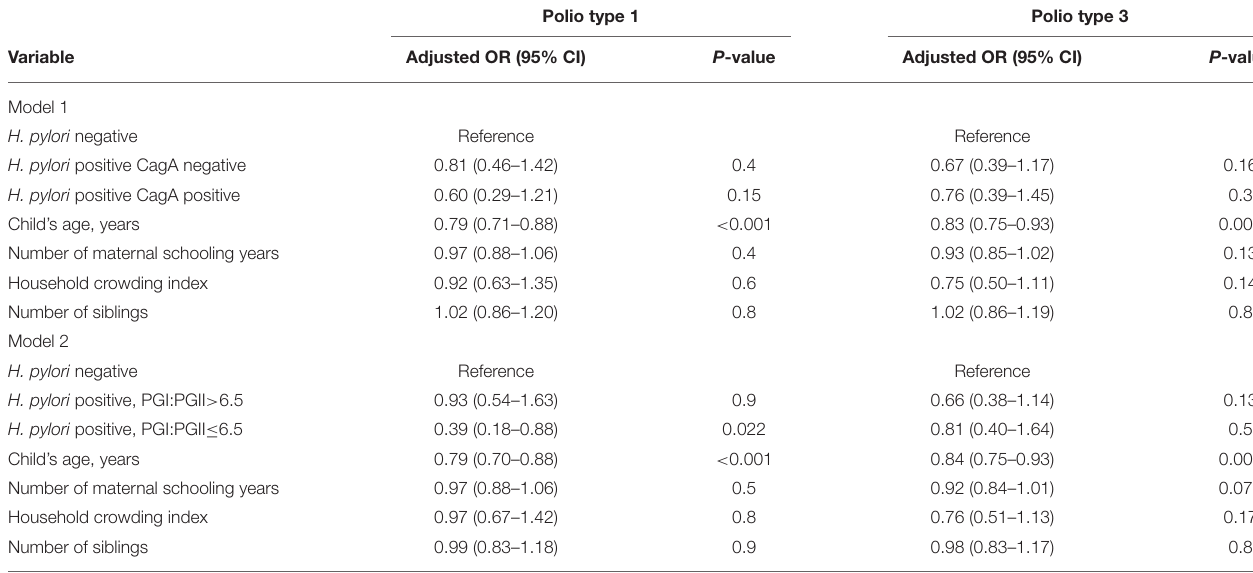
TABLE 5 | Unweighted multivariable logistic regression models of factors associated with high serum neutralizing antibody level (a titer > 1:2,048) against poliovirus type 1 and 3 vaccine